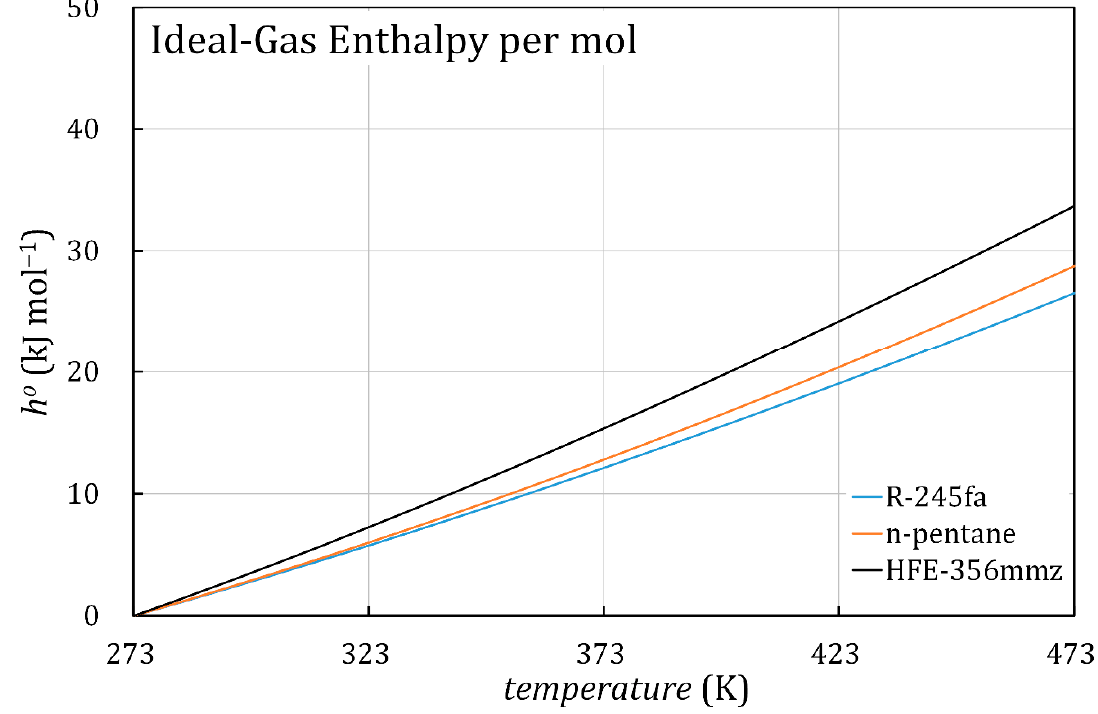
Figure 12. Comparison of the ideal-gas enthalpy per mol of HFE-356mmz with that of R-245fa and n-pentane.